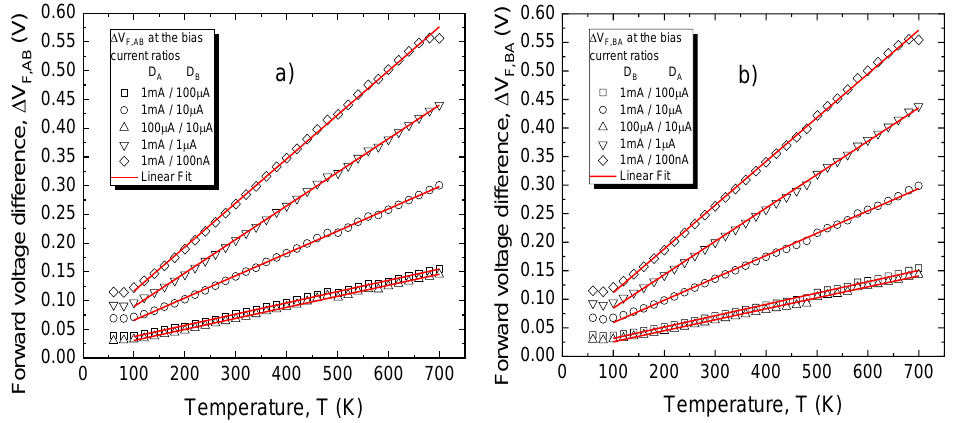
Figure 9. ( a ) ∆V F,AB and ( b ) ∆V F,BA with temperature, for different bias current ratios. A linear regression process was also performed on the characteristics in Figure 9 in order to determine the sensitivity, linearity, and temperature error for the two DDDC configurations, with results plotted in Figure 10, for each current ratio.